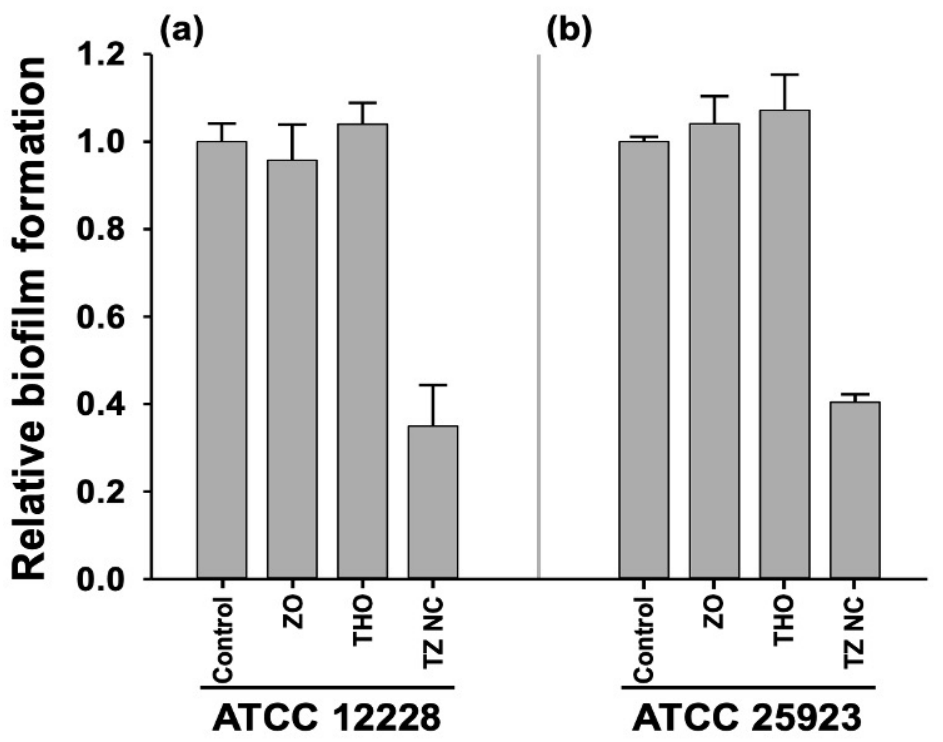
Figure 4. Biofilm formation assays. Relative biofilm formation (OD 595 /OD 600 ) was determined for cells of ( a ) MDR S. epidermidis (ATCC 12228) and ( b ) type S. aureus (ATCC 25923) strains under the presence or absence of ZO, THO, and TZ NC. The values shown in the graphs represent average values with standard deviation of n = 10 experiments ( p < 0.05). The data were analyzed using GraphPad Prism 8 (GraphPad Software Inc., San Diego, CA, USA).